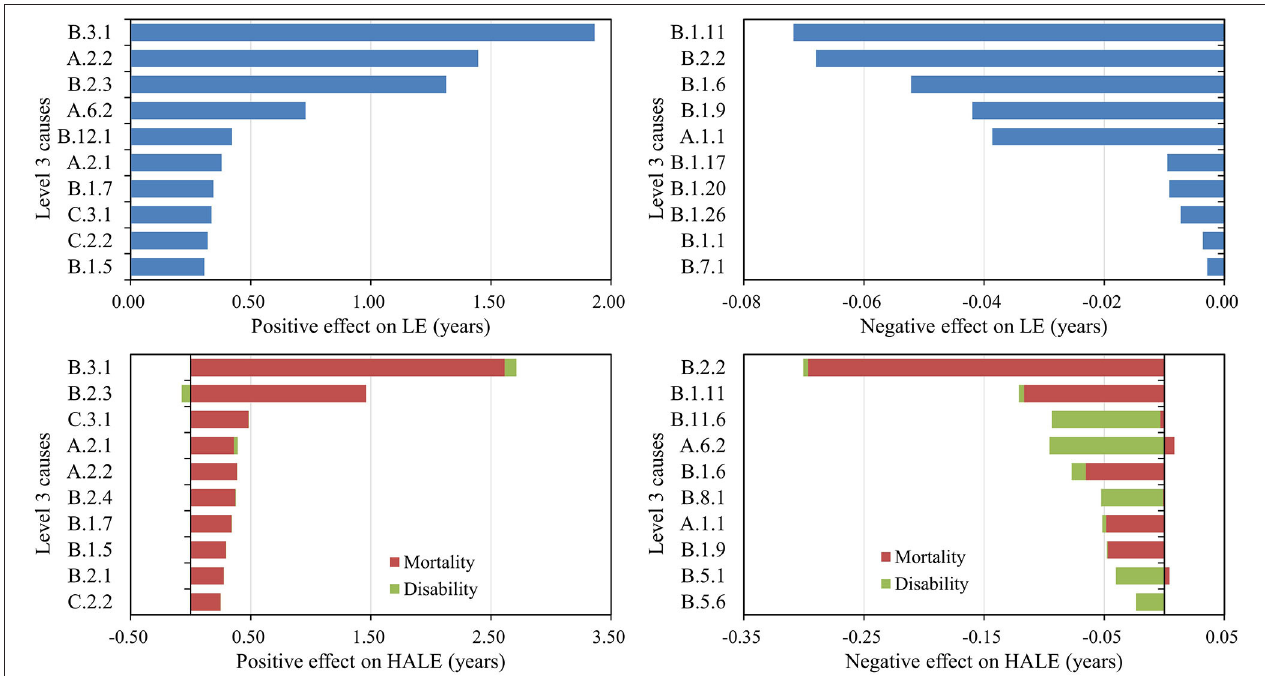
FIGURE 2 | Leading causes with positive/negative effects on changes in life expectancy (LE) and health-adjusted life expectancy (HALE) from 1990 to 2019 (level